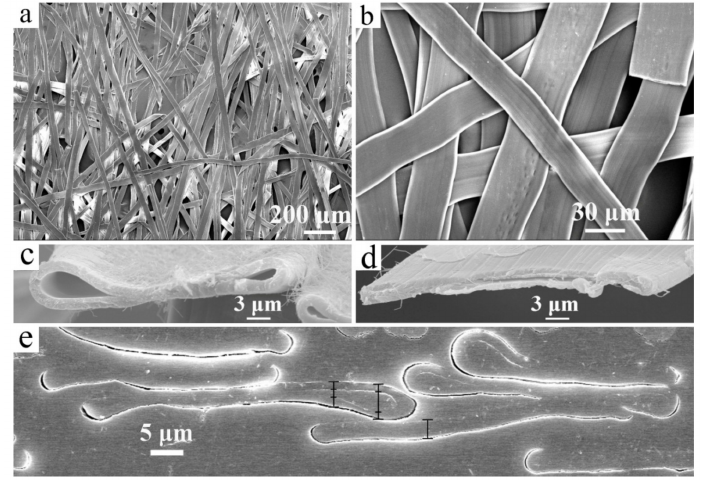
Figure 3. SEM images of ( a , b ) paper; ( c , d ) cross section of a plant fiber; ( e ) cross section of paper embedded in epoxy